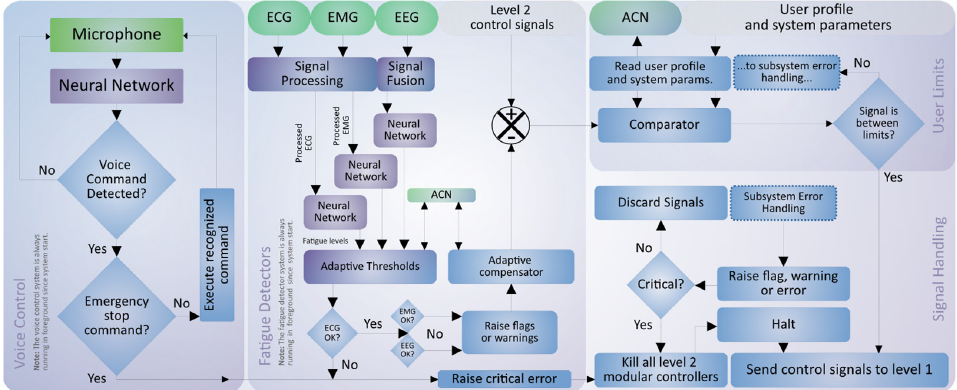
Figure 9. Graphical description of the logical functioning of the main safety system.